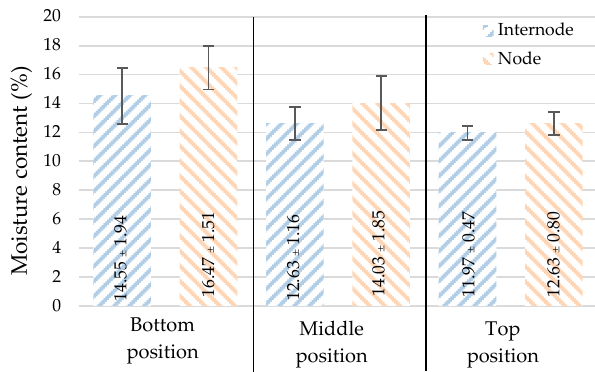
Figure 6. Moisture content (mean ± standard deviation).